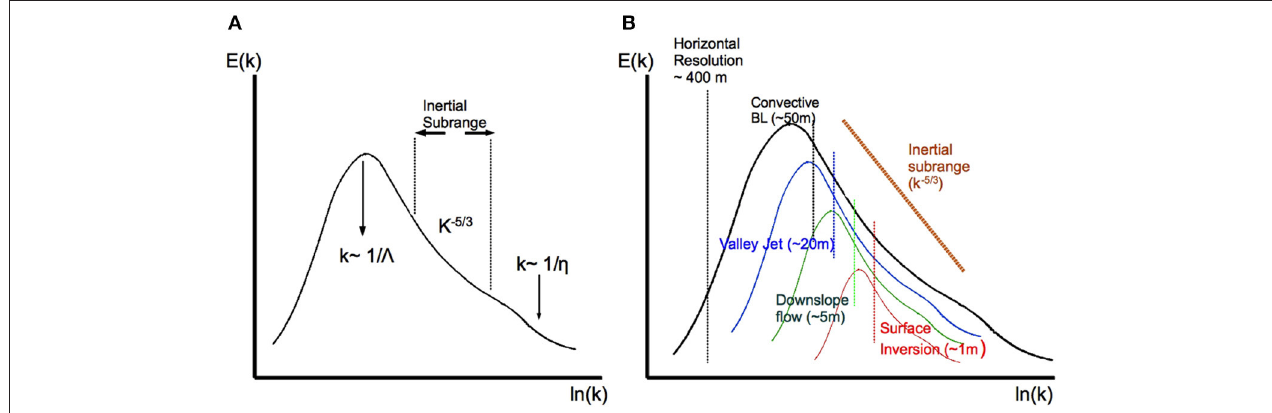
FIGURE 1 | (A) Spectrum for a turbulent flow that has a scale of entrance of energy ( 3 ), a dissipation scale ( η ) and a well defined Inertial Subrange. (B) Conceptual representation of the Inertial Subranges corresponding to different structures in a valley flow. The vertical lines indicate the typical scale of the upper size of the Inertial